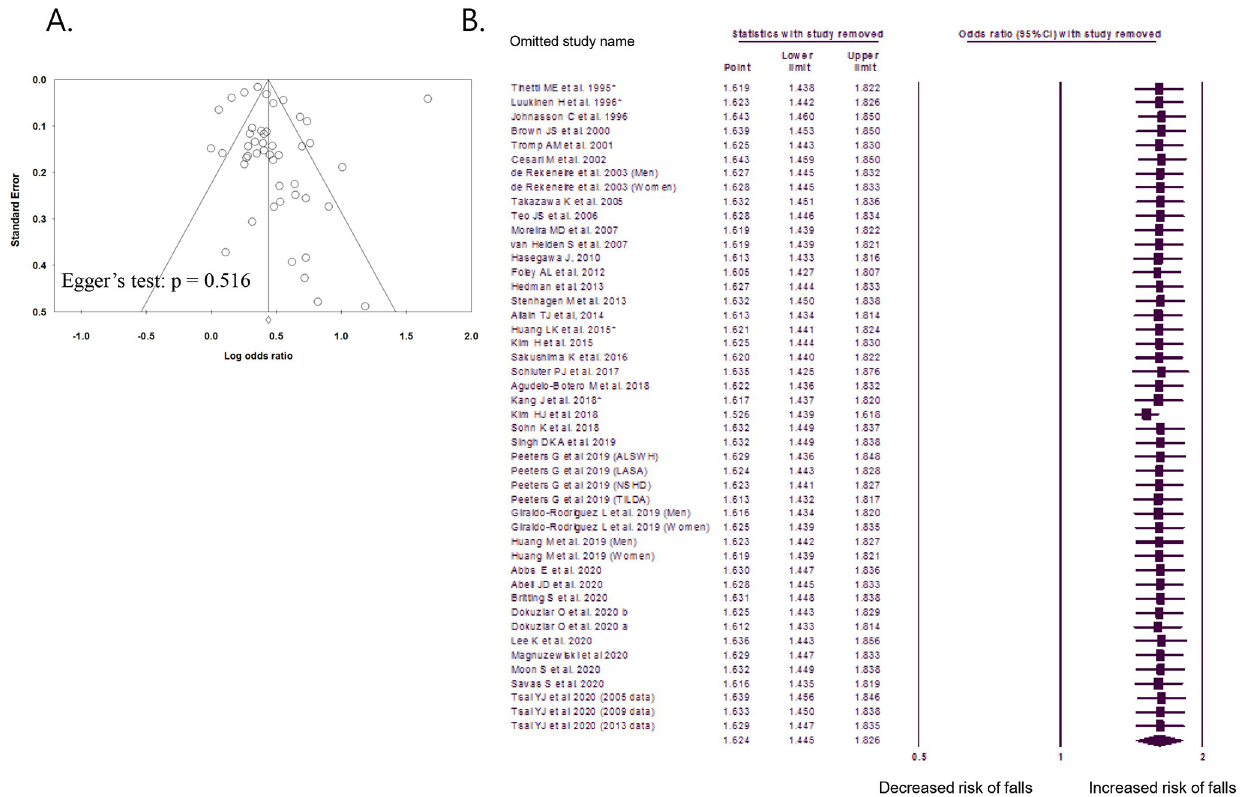
Fig 4. Funnel plot and sensitivity analysis. A. Funnel plot of publication bias in studies comparing the odds ratios of urinary incontinence for falls. B. Sensitivity analysis of the meta-analysis of studies comparing the odds ratios of urinary incontinence for falls. � Study that defined falls as at least two falls within 1 year.